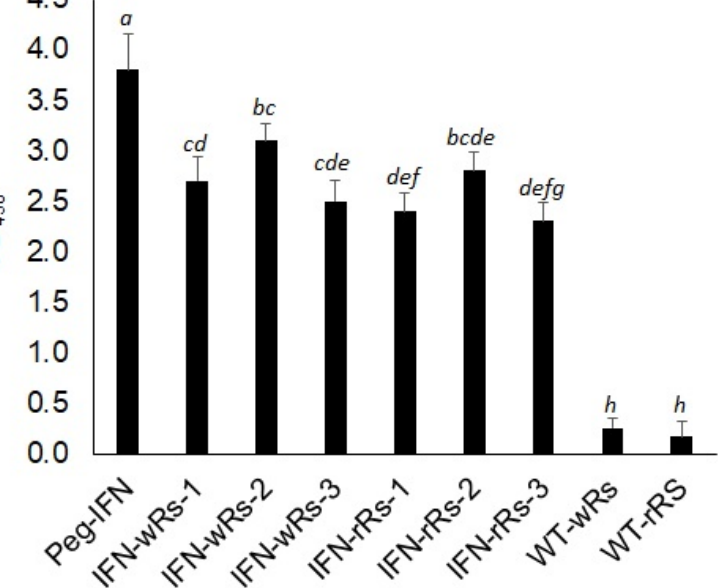
Figure 5. Enzyme-linked Immunosorbent Assay (ELISA) detection for IFN- α 2a in wild-type and transgenic Raphanus sativus L. plants. Shown are OD 450 values recorded for recombinant IFN- α 2a samples and Peg-IFN (commercially available IFN- α (Pegasys ® ; Hoffmann-LaRoche, Basel, Switzerland)). IFN-wRs-1–3: total protein extracts isolated from three independent transgenic lines of IFN- α 2a- transgenic white Raphanus sativus L. plants. IFN-rRs-1–3: total protein extracts isolated from three independent transgenic lines of IFN- α 2a-transgenic red Raphanus sativus L., WT-wRs: wild-type white Raphanus sativus L. protein extracts. WT-rRs: wild-type red Raphanus sativus L. protein extracts. Data represent the average OD 450 values recorded from at least 4 independent measurements ± SE. Different small letters represent significant differences; p = 0.01.